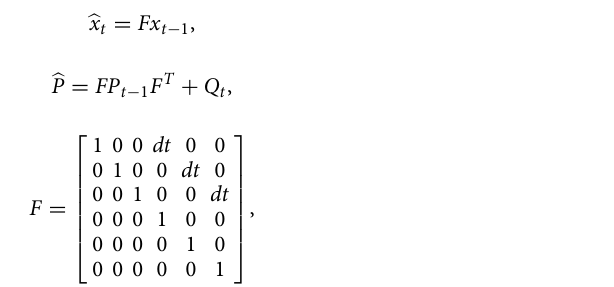
Figure 3. The bounding box is represented by the yellow frame. The centroid position ( c x by the yellow dot. The end of the head position ( p x movement of the fish is represented by the green arrow that has an angle equal to c θ